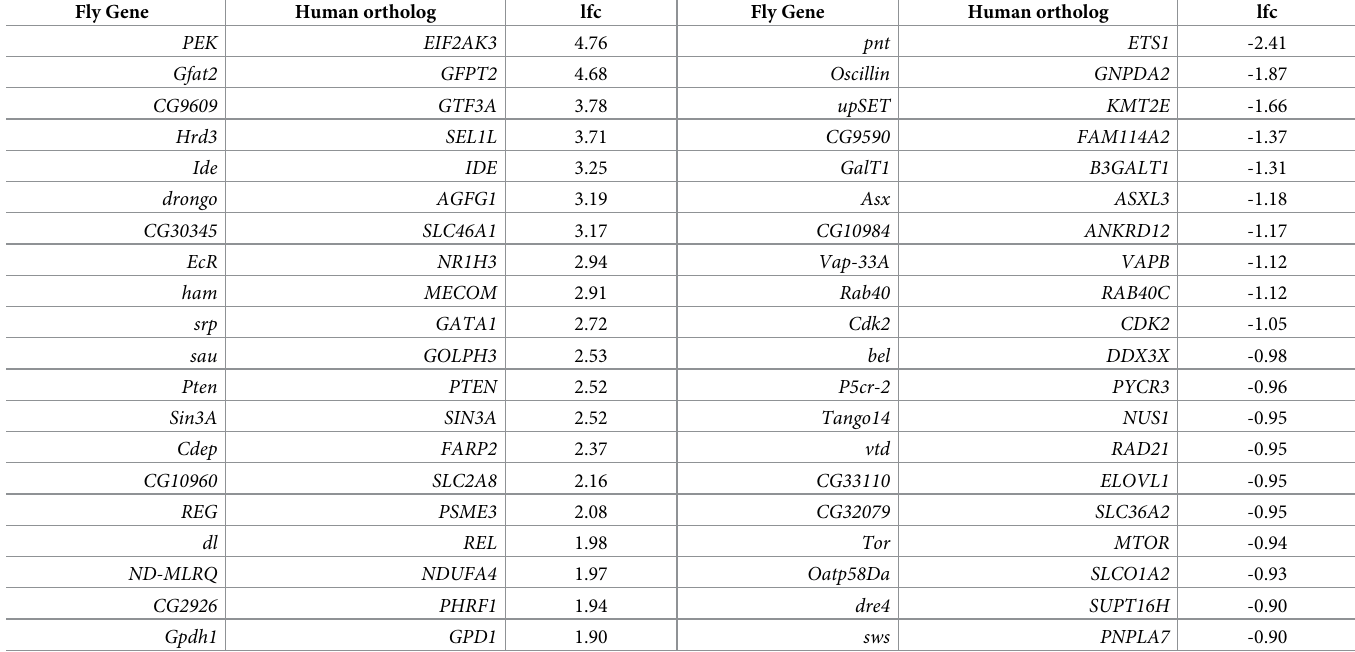
Human orthologs are based on the highest DIOPT score [26].